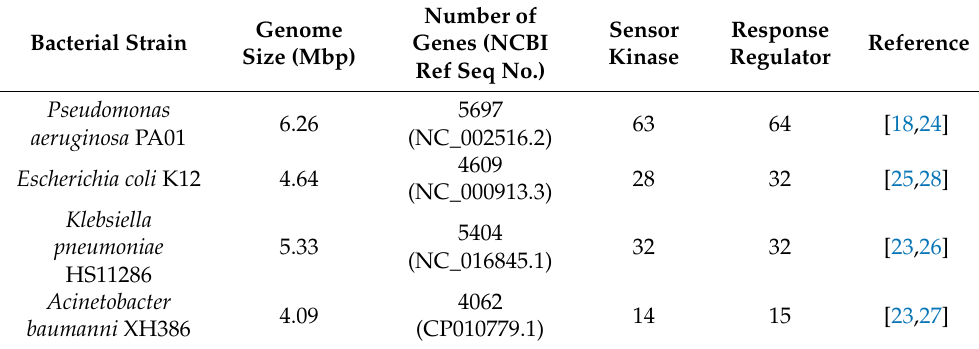
Table 1. Summary of genome size and TCSs of P. aeruginosa with other Gram-negative pathogens. Bacterial Strain